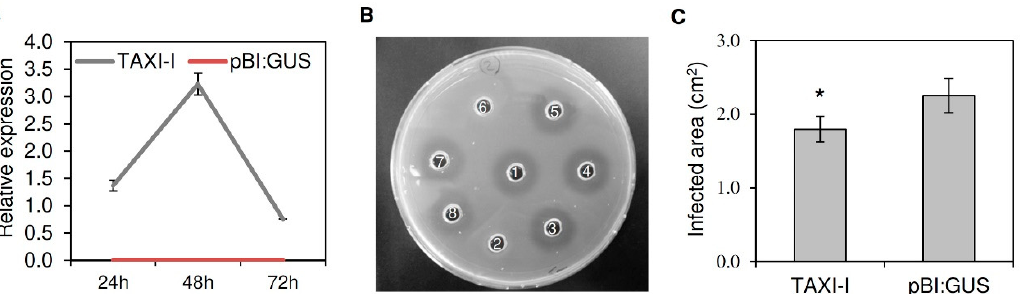
Figure 1. Characterization of Nicotiana tabacum leaves agro-infiltrated with Triticum aestivum TAXI-I and pBI:GUS and inoculated with Botrytis cinerea. ( A ) Relative expression of TAXI-I transcript was determined by RT-qPCR in N. tabacum agro-infiltrated leaves at di ff erent time points post-agro-infiltration. Relative expression was normalized with the tobacco actin gene set to 1. Data represent the average ± standard error of two independent experiments. ( B ) Radial gel di ff usion assay to quantify the xylanase inhibition activity. A total of 70 ng of BcXyn11a were incubated alone or in the presence of 20 µ g of total native or boiled protein extracts obtained from N. tabacum plants agro-infiltrated with TAXI-I or pBI:GUS. Samples: (1) BcXyn11a; (2) BcXyn11a + native TAXI-I extract; (3) BcXyn11a + boiled TAXI-I extract; (4) BcXyn11a + native pBI:GUS extract; (5) BcXyn11a + boiled pBI:GUS extract; (6) BcXyn11a + purified TAXI-I; (7) BcXyn11a + boiled purified TAXI-I; (8) BcXyn11a + McIlvaine’s bu ff er. The absence of the halo indicates the presence of inhibition activity. ( C ) Lesion area produced by B. cinerea (strain B05.10) on tobacco leaves expressing TAXI-I or pBI:GUS at three days post-inoculation (dpi). Bars indicate the standard error (SE) calculated from three independent infection experiments. * indicates significant di ff erences at p < 0.05 applying the Student’s